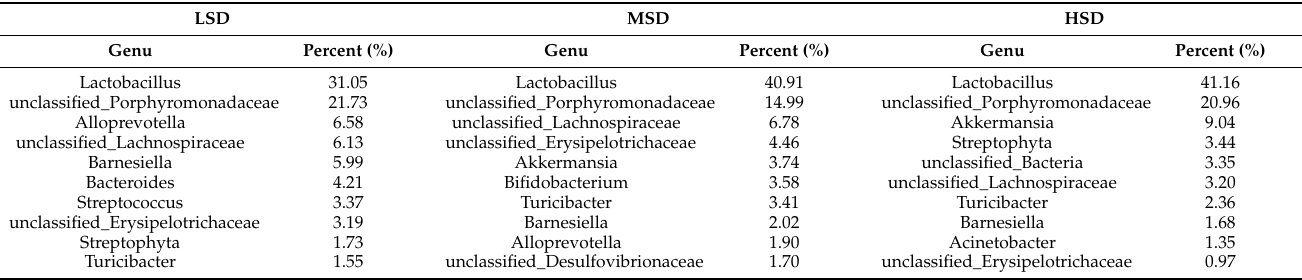
Figure 5. Multi-stage species composition analysis of single sample. ( A ) Partial least squares discriminant analysis (PLS-DA) of the samples. Each sample was represented as a point. ( B ) Relative abundance of the most abundant bacterial phylum. ( C ) Relative abundance of the most abundant bacterial genu. ( D ) The heat map showing the composition of the phylum-level microbiota combined with the results from the cluster analysis. ( E ) The heat map showing the composition of the genu-level microbiota combined with the results from the cluster analysis. Table 4. Statistics of bacterial abundance of Kunming mice in low density group, medium density group, and high stocking density group in